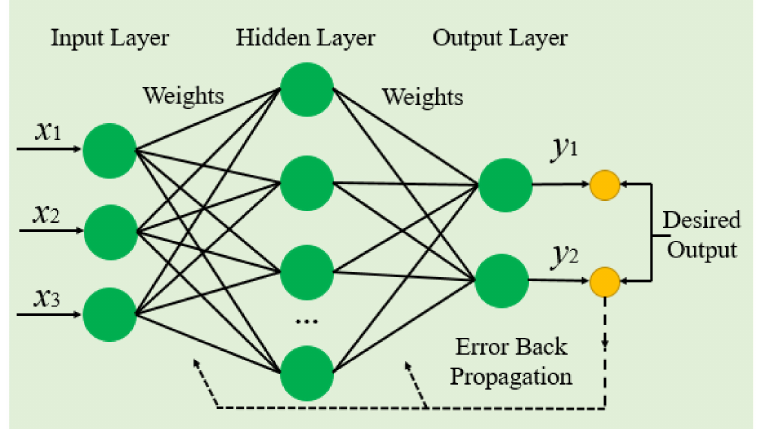
Figure 3. Schematic diagram of Back Propagation (BP) neural